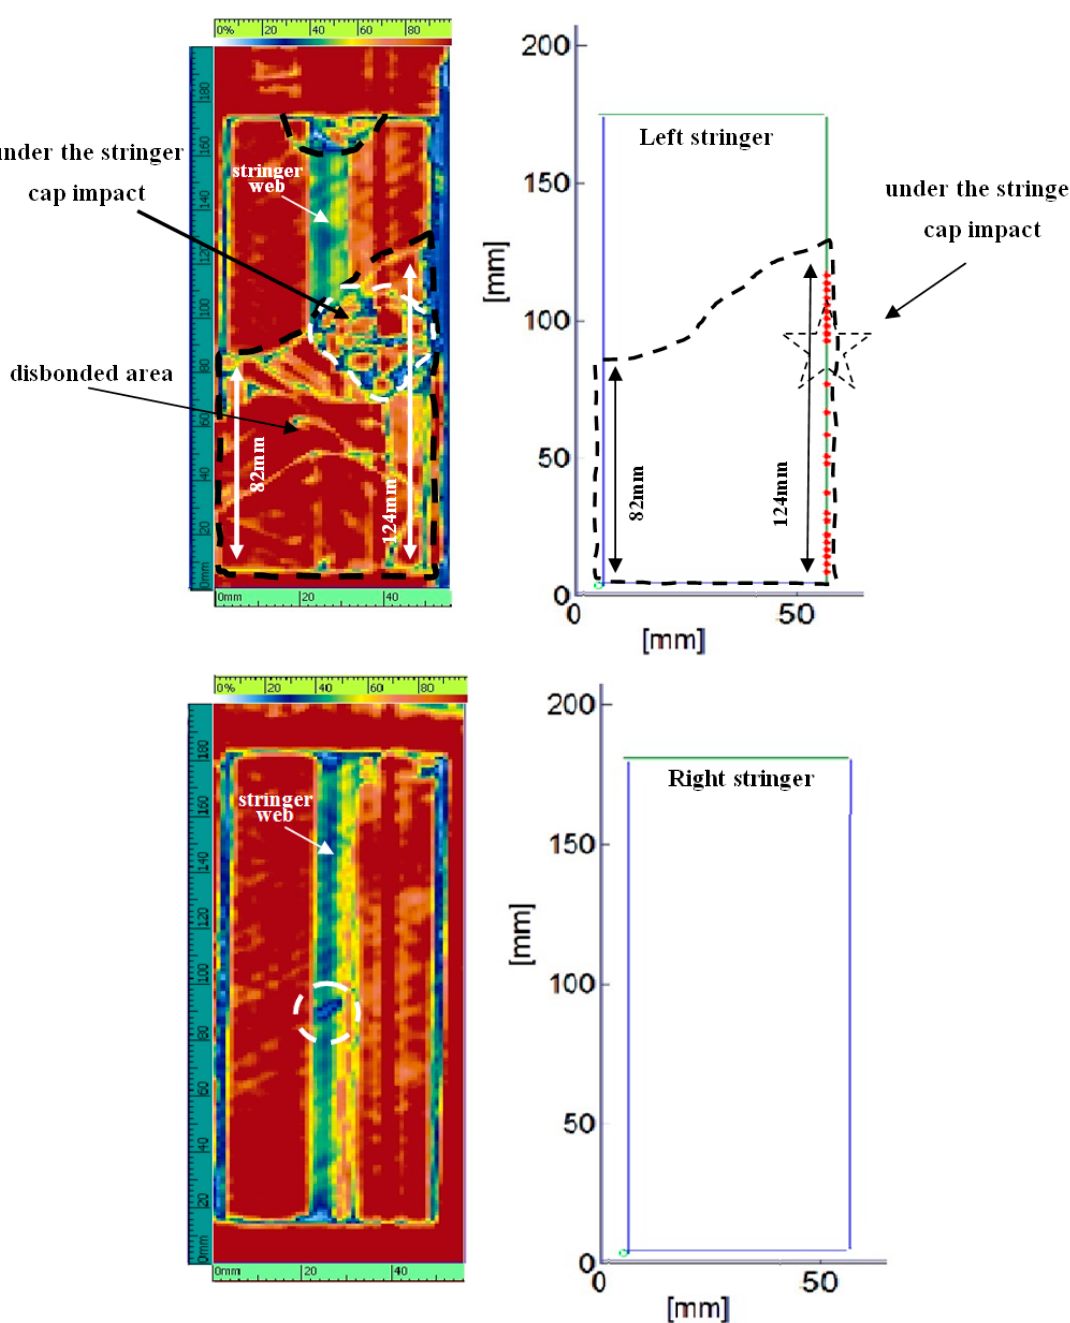
Figure 16. Panel PNL2: left ( upper ) and right ( bottom ) stringers C-scan amplitude views—scan length 200 mm.